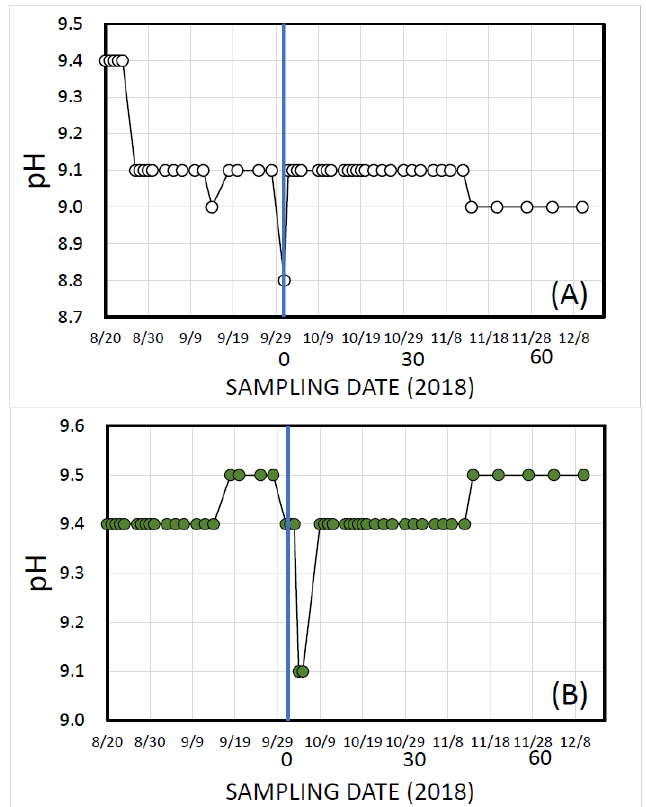
Figure 6. Changes in pH values during the experiments. ( A ): in the emulsion-type cutting fluid (E-CF); ( B ): in the soluble-type cutting fluid (S-CF). Blue vertical lines show the day when bubbling with microbubbles was initiated (1 October). Numbers of 0, 30, and 60 below the date in each figure show days after starting to supply microbubbles.